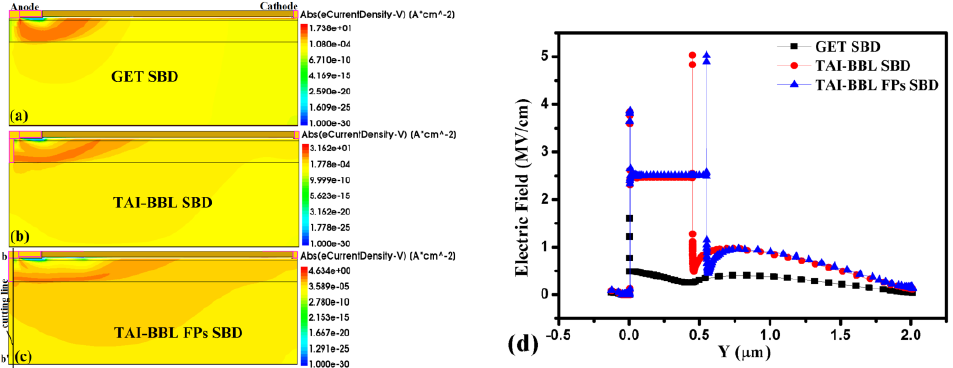
Figure 6. The path of the anode leakage current of: ( a ) GET SBD, ( b ) TAI-BBF SBD, ( c ) TAI-BBF FP SBD, ( d ) the corresponding vertical electric field distribution under the SC.